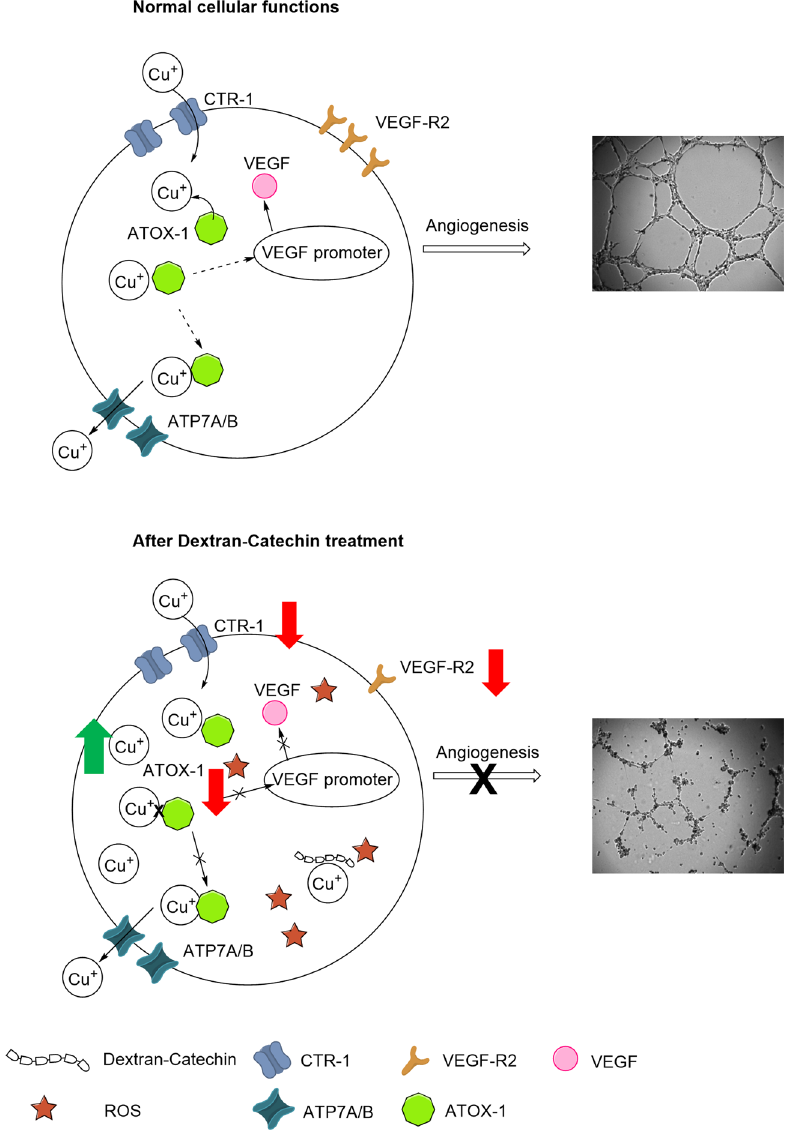
Figure 7. Proposed model of the mechanism of Dextran-Catechin targeting copper homeostasis in endothelial